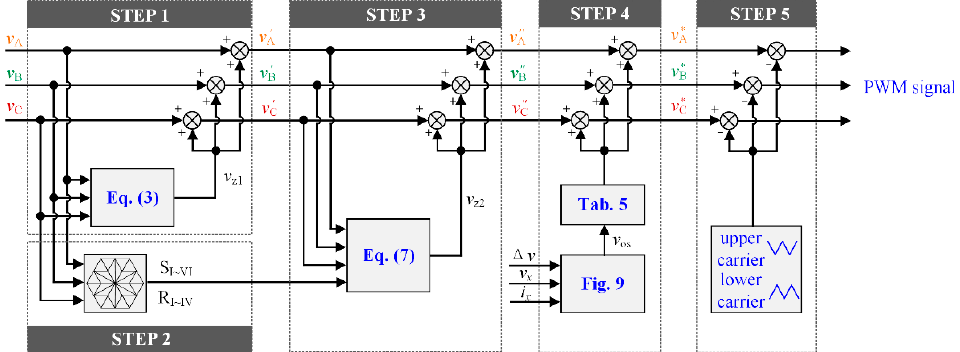
Figure 10. Block diagram of the proposed DPWM strategy.